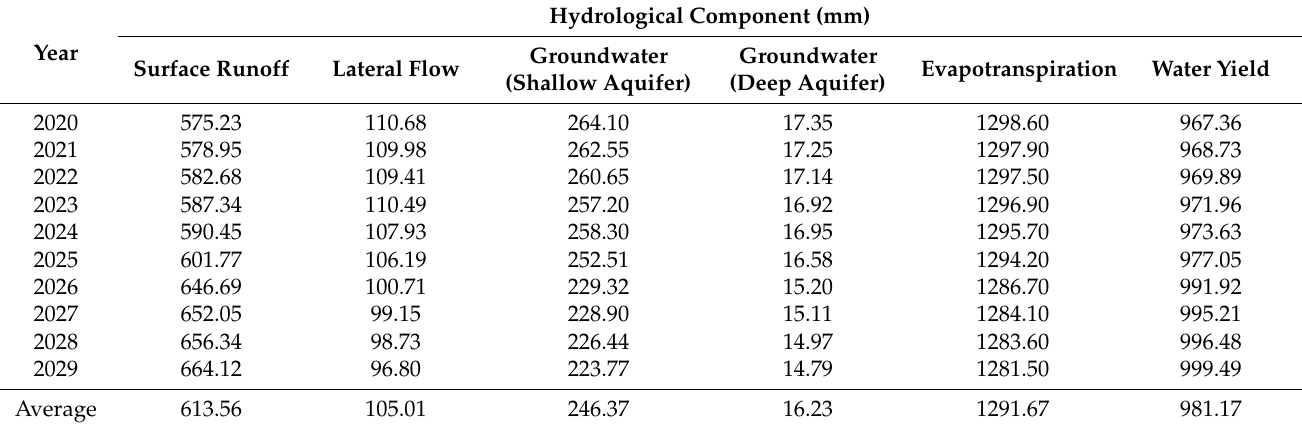
Table 16. Annual water yield of Phuket Island between 2020 and 2029 under dry year scenario.